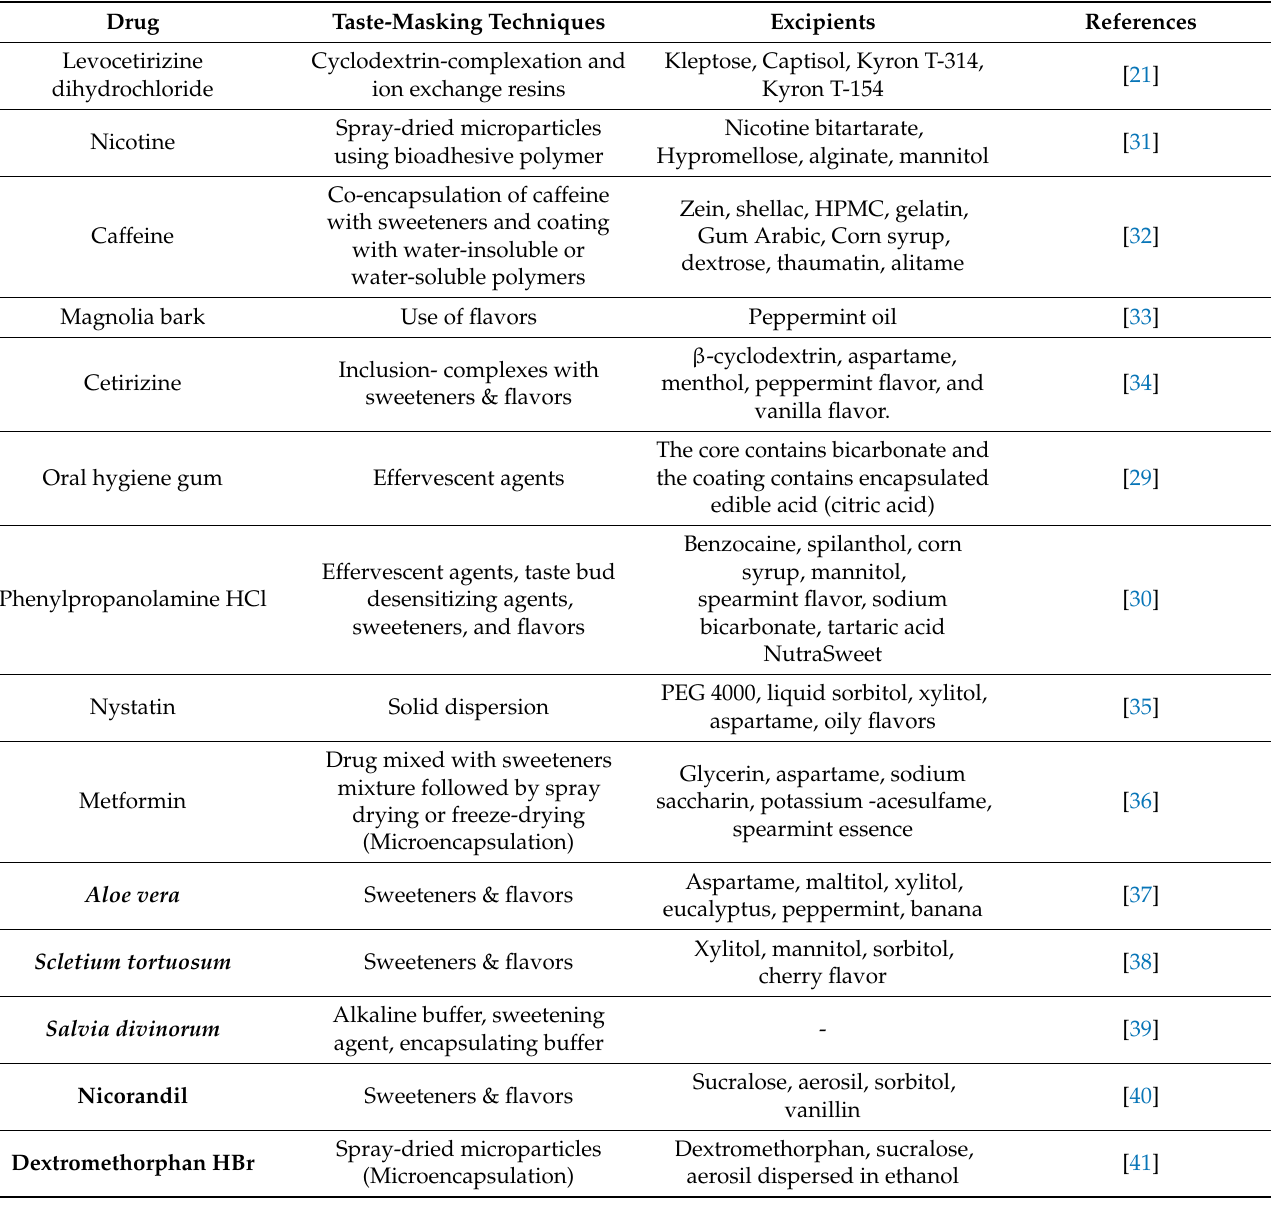
Table 1. Taste masking of Medicated Chewing gums by different